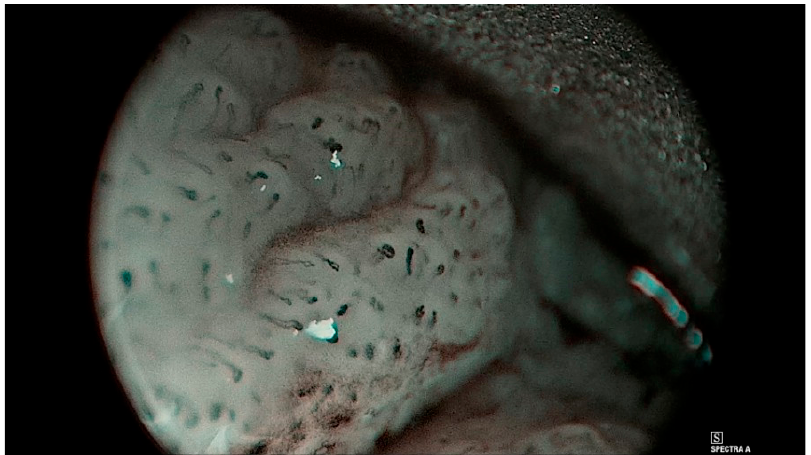
Figure 3. Histologically verified supraglottic squamous cell carcinoma. Ni type Vb of the mucosal vascularization, ELS classification—perpendicular type of vascularization.